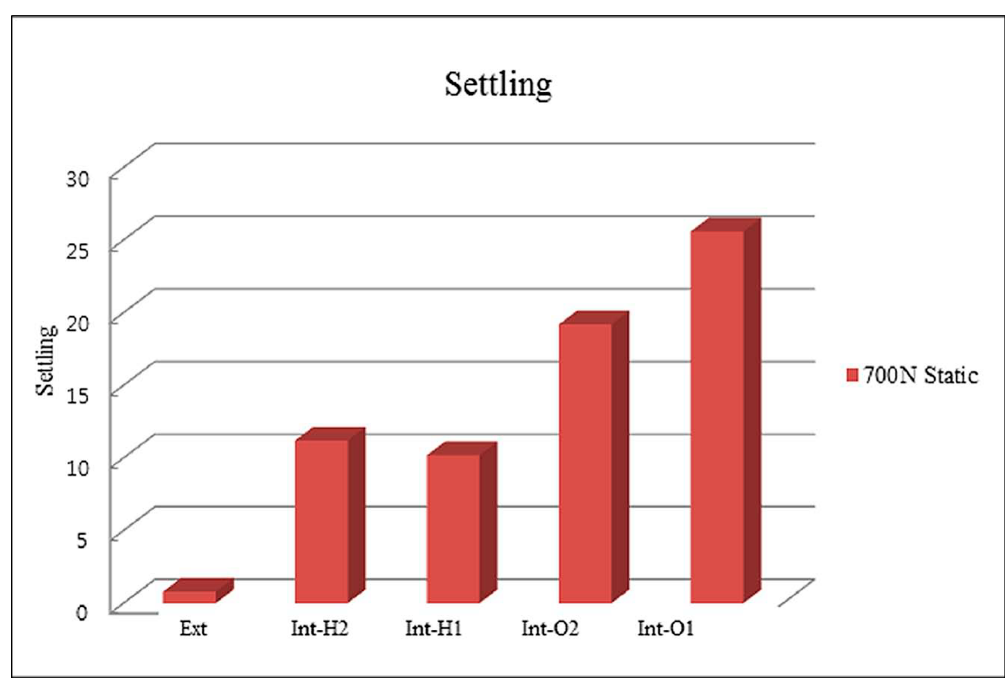
Figure 4. Settling of abutments into the implants after static loading ( µ m).